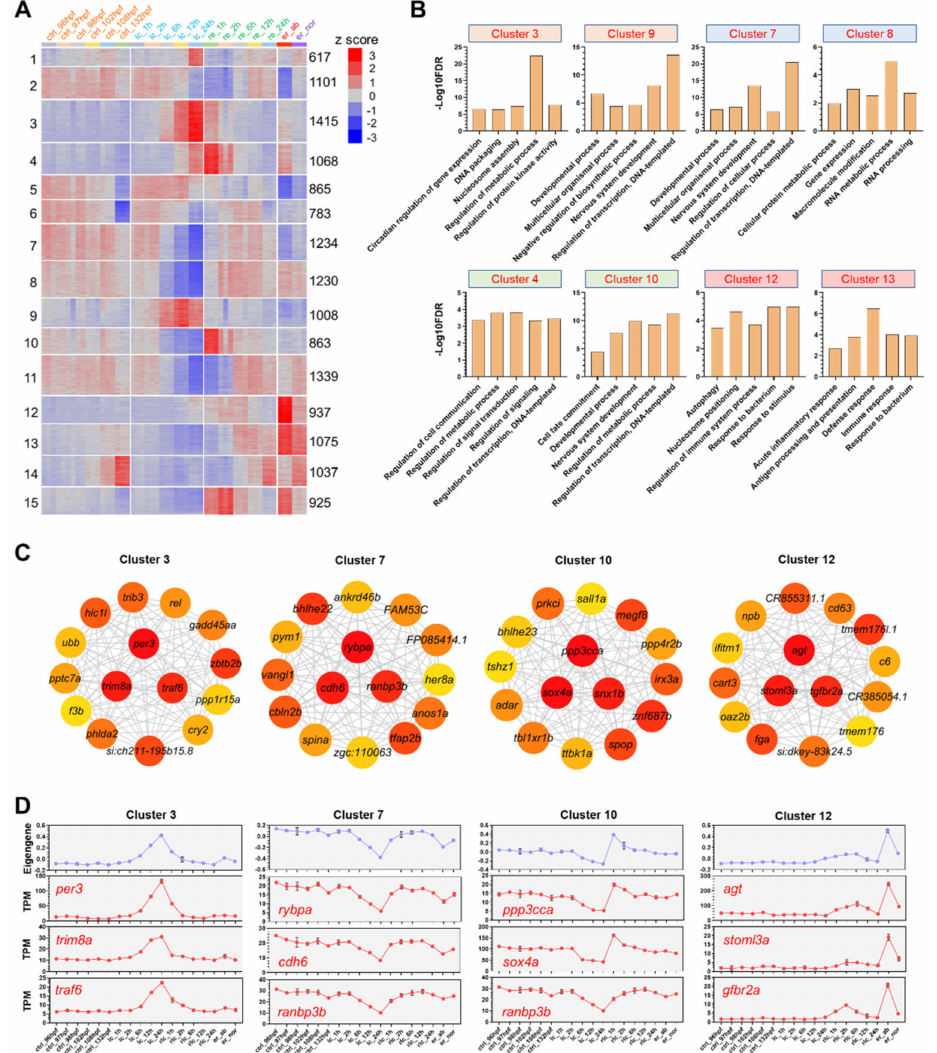
Figure 3. Clustering analysis, gene ontology (GO) enrichments and coexpression networks of the DEGs. ( A ) K-means clustering of the DEGs. Numbers of the clusters are displayed on the left. Numbers of genes in each cluster are shown on the right. The color scale indicates row z- score. ( B ) GO enrichments (biological process) for the representative clusters. ( C ) Hub genes of the indicated clusters. The gene coexpression network for each cluster was constructed by weighted gene coexpression network analysis (WGCNA) and the top 15 genes with the highest maximal clique centrality (MCC) were shown. The top 3 hubs were located in the middle of the circle. Color of node is proportional to the MCC. ( D ) Eigengene depicting overall gene expression of the representative clusters and expression of the top 3